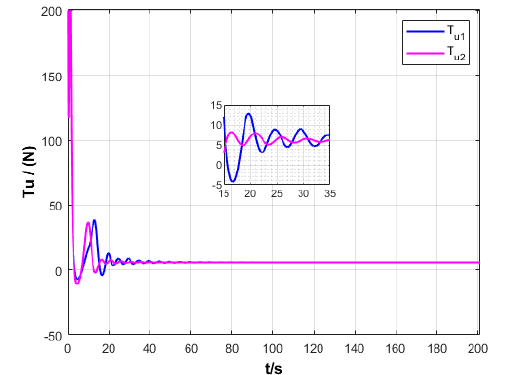
Figure 7. Forward thrust of USV under two strategies.